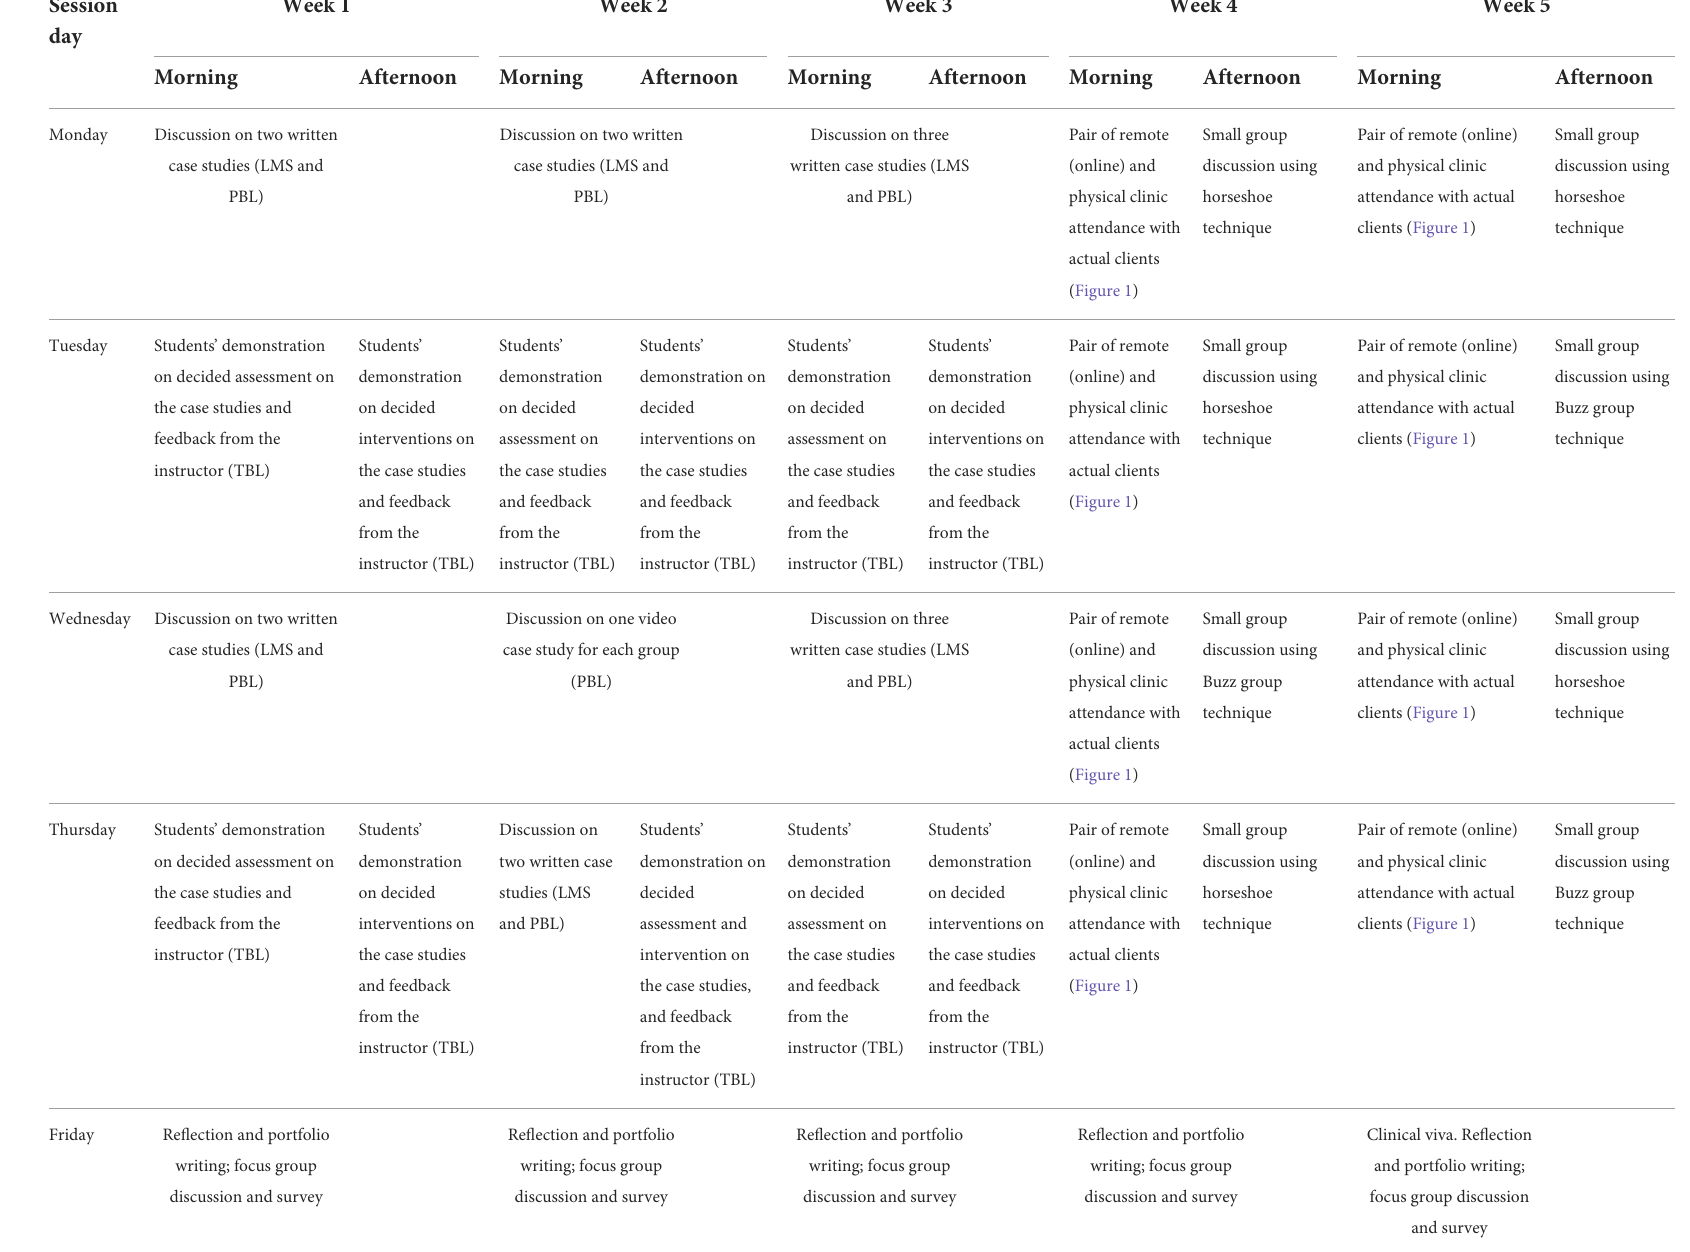
TABLE 2 Timetable for the clinical